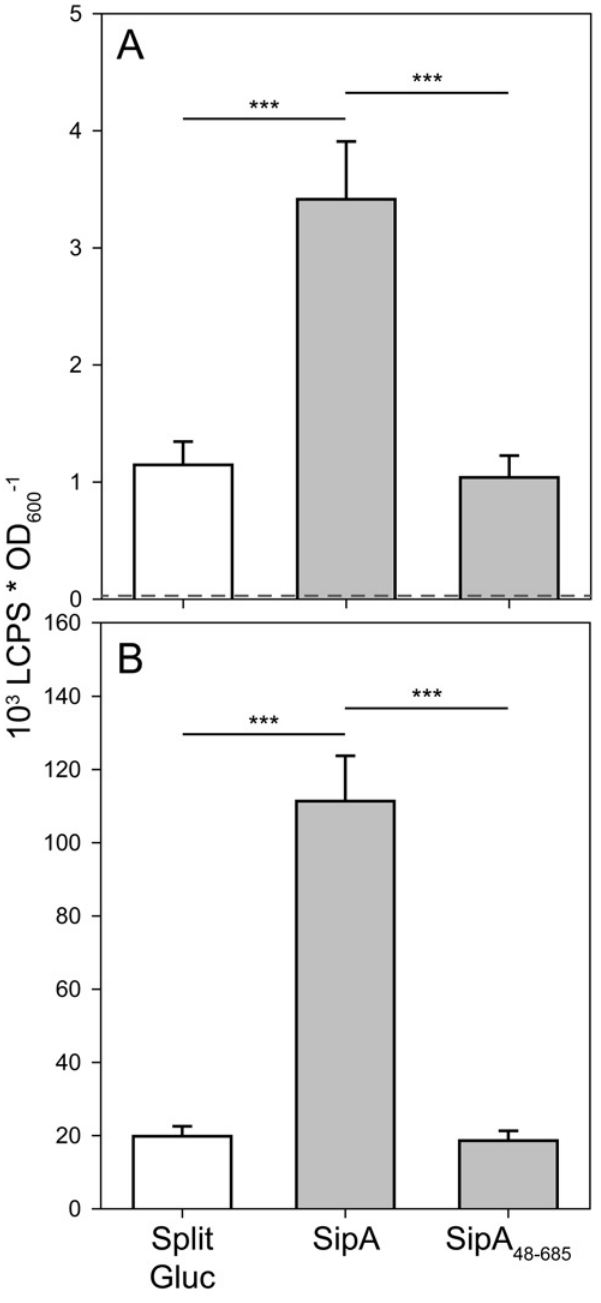
Fig 5. Gateway-based split Gluc protein complementation assay (PCA) for detection of chaperone- effector interaction. Expression clones encoding InvB fused to Gluc M43L 105 and SipA or a SipA variant lacking its CDB (SipA 48 – 685 ) fused to Gluc M110L 106 or Gluc M43L 105 and Gluc M110L 106 alone (split Gluc) were transferred into S . Typhimurium and expression was induced with 50 ng * ml -1 AHT. Gluc activity was quantified from intact cells (A) and bacterial lysates (B). The dotted line in (A) represents the background luminescence determined with an empty vector control (pWSK29). Mean and standard deviation out of three independent experiments done in triplicate is shown. Statistical analysis by Student ’ s t -test was done by comparing individual strains as depicted: *** , P <